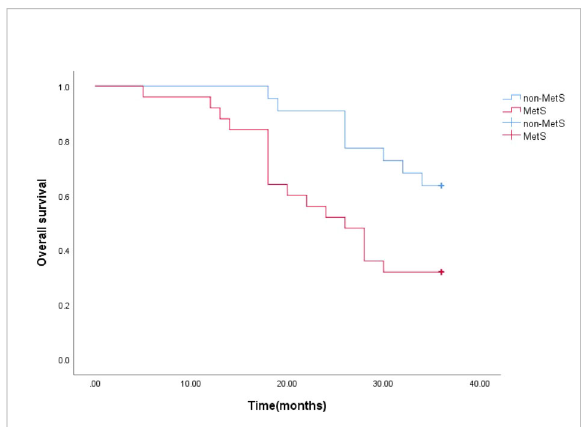
FIGURE 6 Overall survival curves for mPCA patients with MetS and non-